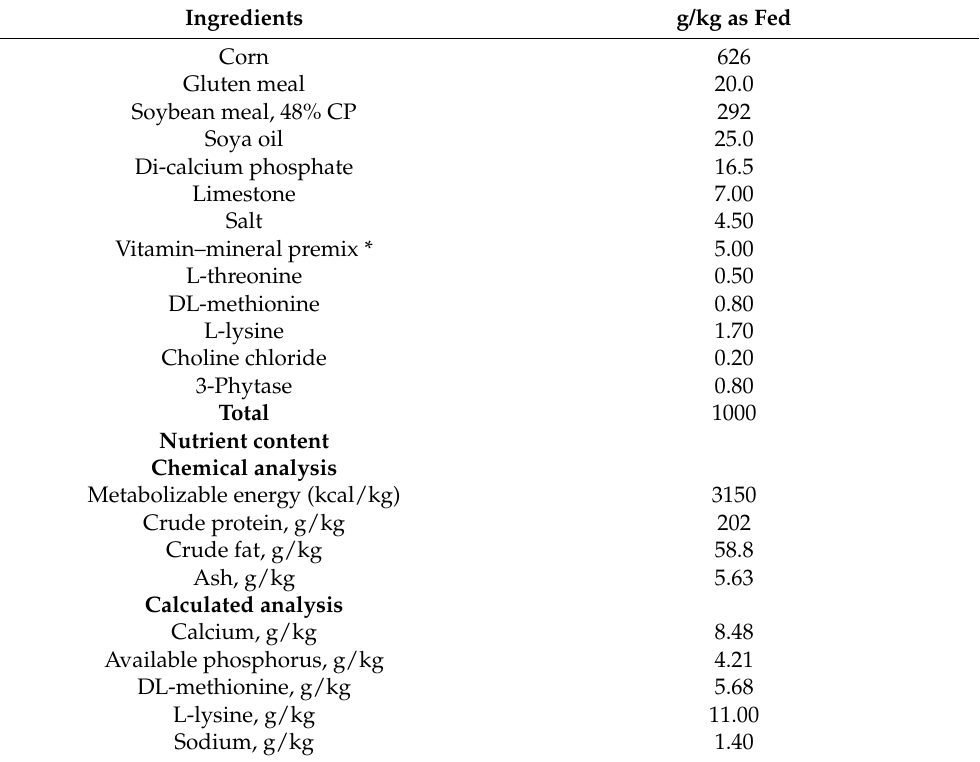
Table 1. Ingredients and nutrient composition used of the experimental diets as fed basis (days 22 to